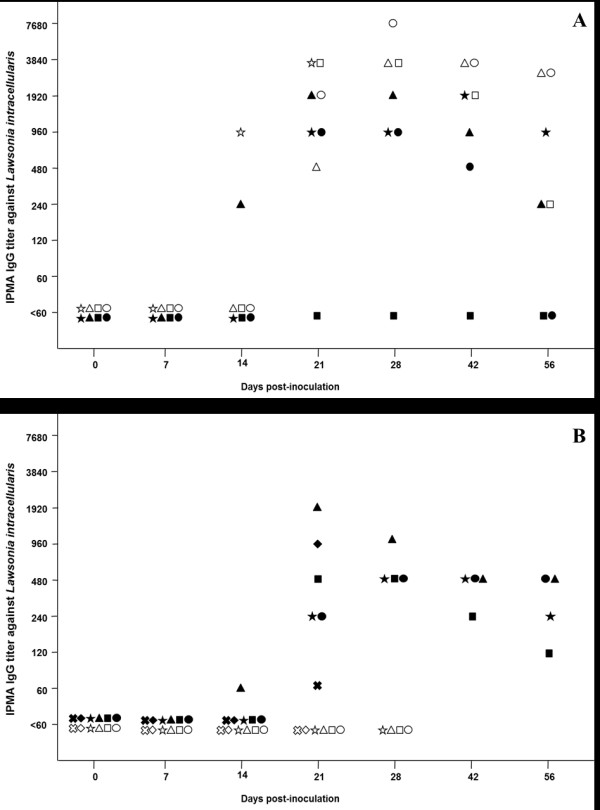
Serologic response against L. intracellularis throughout the study period. A) Foal experiment. B) Pig experiment. White points represent animals infected with the equine isolate and black points represent animals infected with the porcine isolate.